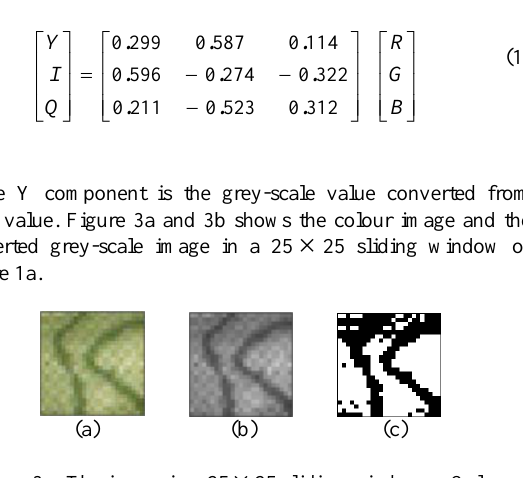
Figure 3. The image in a 25 × 25 sliding window. a Colour image. b Gray-scale image. c Segmentation by thresholding 3.1.2